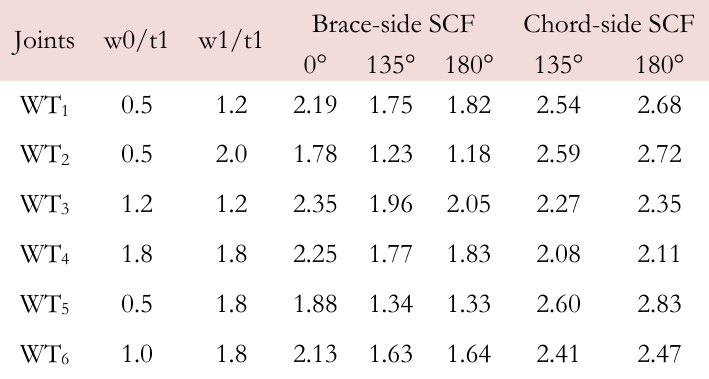
Table 2: SCF in Condition 2.